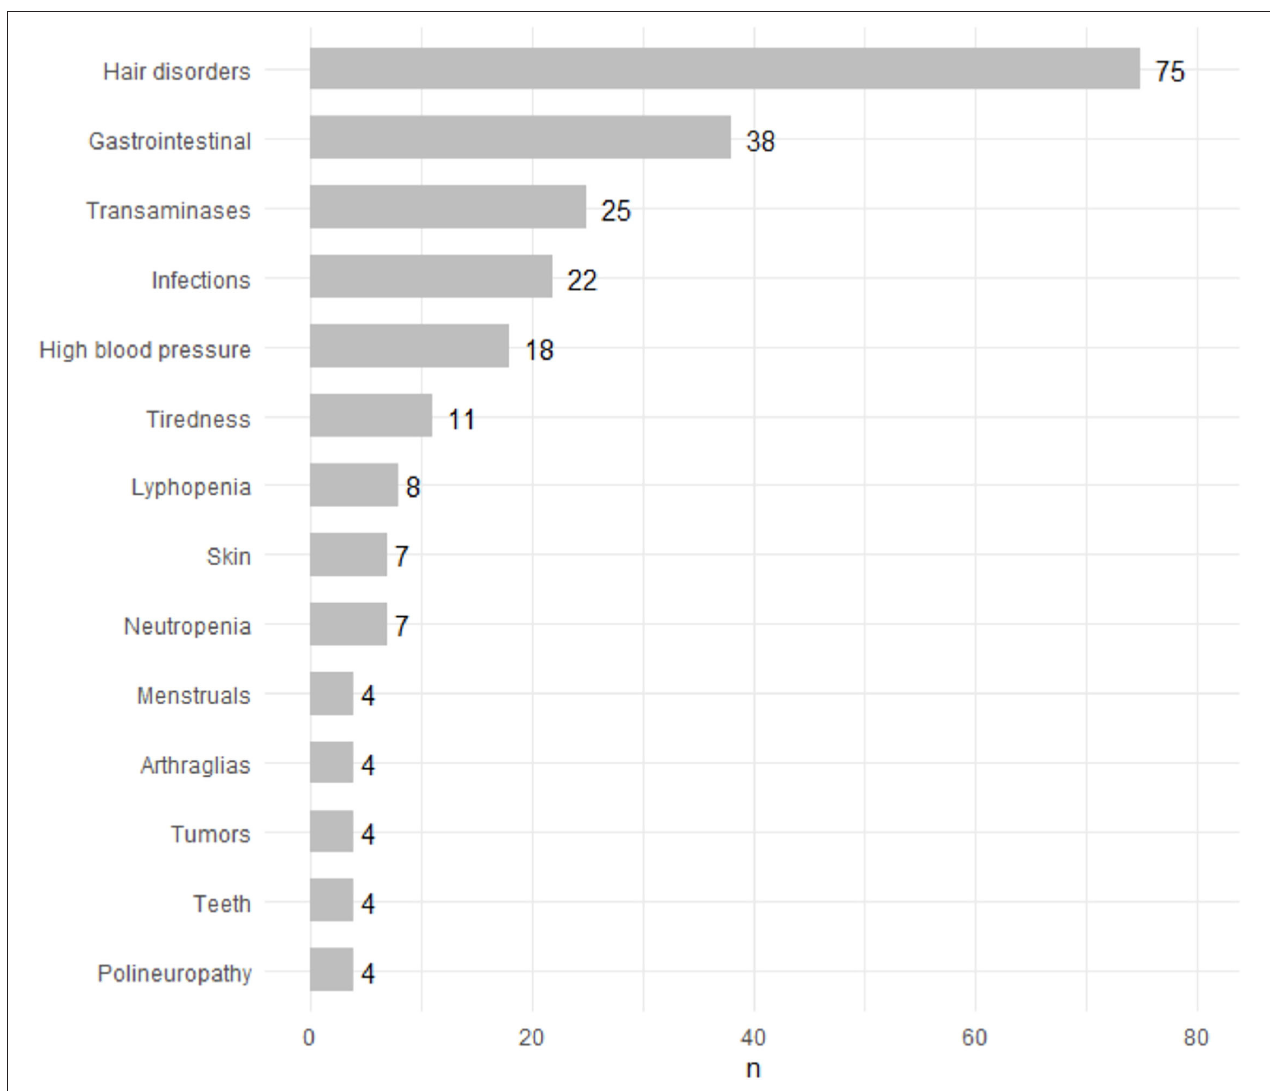
FIGURE 8 | Adverse